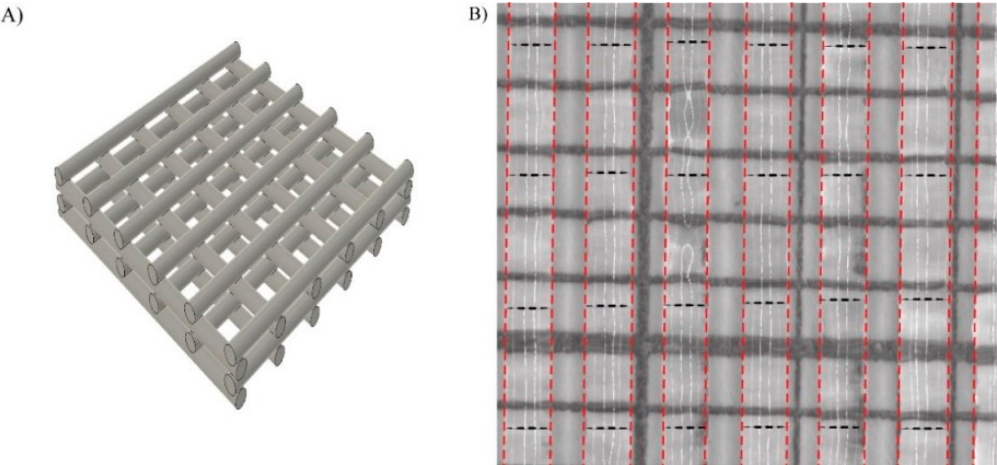
Figure 2. Design of scaffold and printability of TEMPO-CNF ( A ) Schematic illustration of the printed grid model. ( B ) One layer of printed TEMPO-CNF strands on mm-marked paper (black solid lines in the image) to determine the strand width. The strands are marked with red dotted lines and the measurement position is marked with black dotted lines.